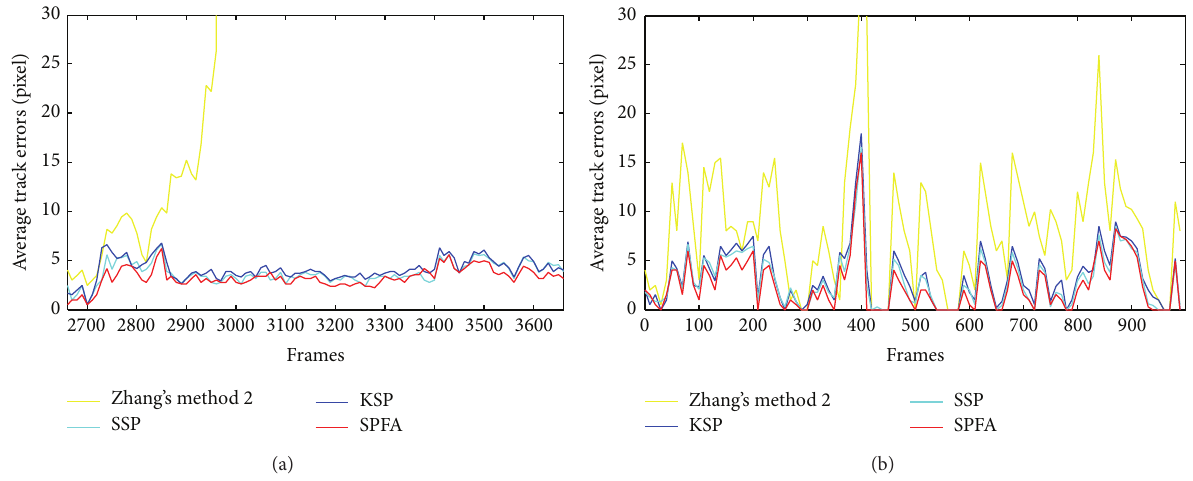
Figure 11: The comparison of the average tracking errors with Sequence3 of the BEHAVEDATA dataset (a) and Seq03view1 of the ETHMS dataset (b).